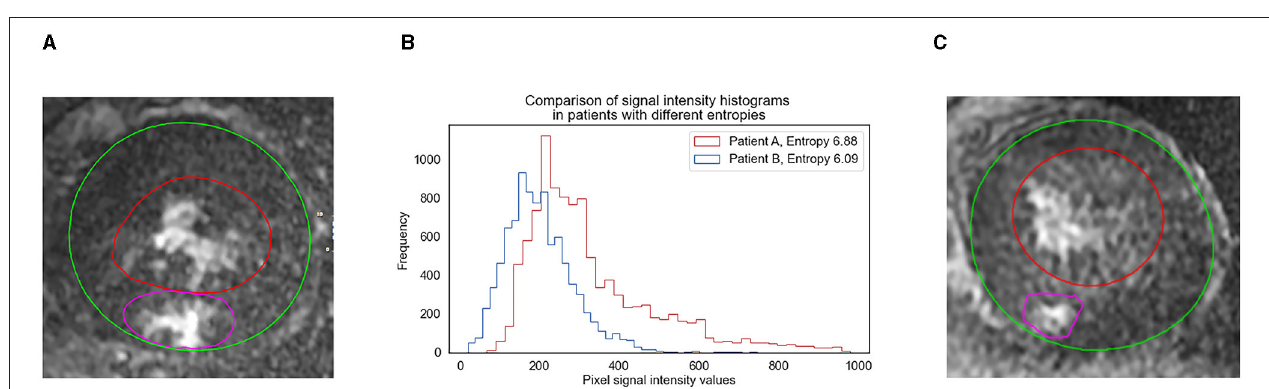
FIGURE 2 | (A) Levels of scar entropy in HCM patients with or without ventricular arrhythmia (VA) (Groups VA and non-VA). (B) The receiver operator characteristic (ROC) curve of the scar entropy to predict the presence of VAs in the HCM cohort. AUC, area under the curve; CI, confidence interval; HCM, hypertrophic cardiomyopathy; VAs, Ventricular arrhythmias; The ROC curve of the percentage of the LGE (%LGE), scar entropy, and combined %LGE and scar entropy to predict the presence of VAs in the HCM cohort.